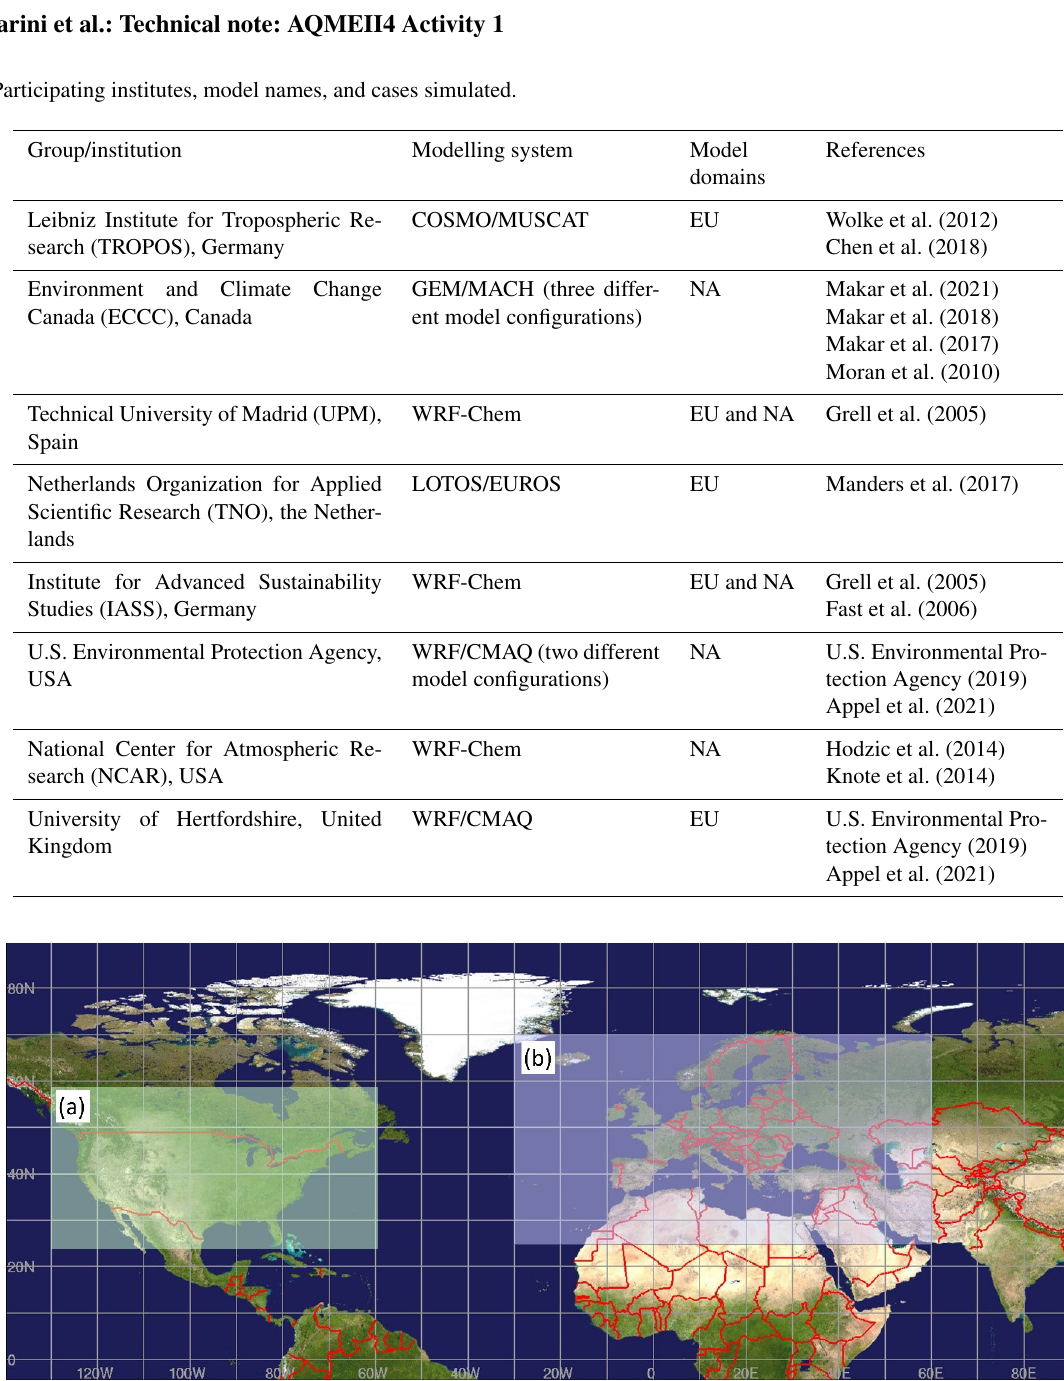
Figure 1. AQMEII4 North American (a) and European (b) 0.125 ◦ grid cell size common latitude–longitude comparison